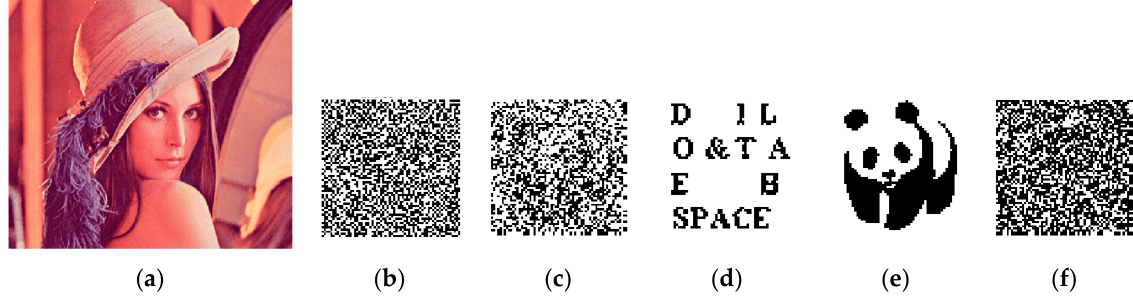
Figure 8. Simulation experiment of destroying robust watermark: ( a ) carrier image after being attacked; ( b ) the robust watermark ciphertext extracted from ( a ); ( c ) decrypted robust watermark; ( d ) the fragile watermark extracted and decrypted from ( a ) (1 is the same as 2); ( e ) the original decrypted robust watermark; ( f ) XOR image representing ( c ) and ( e ).